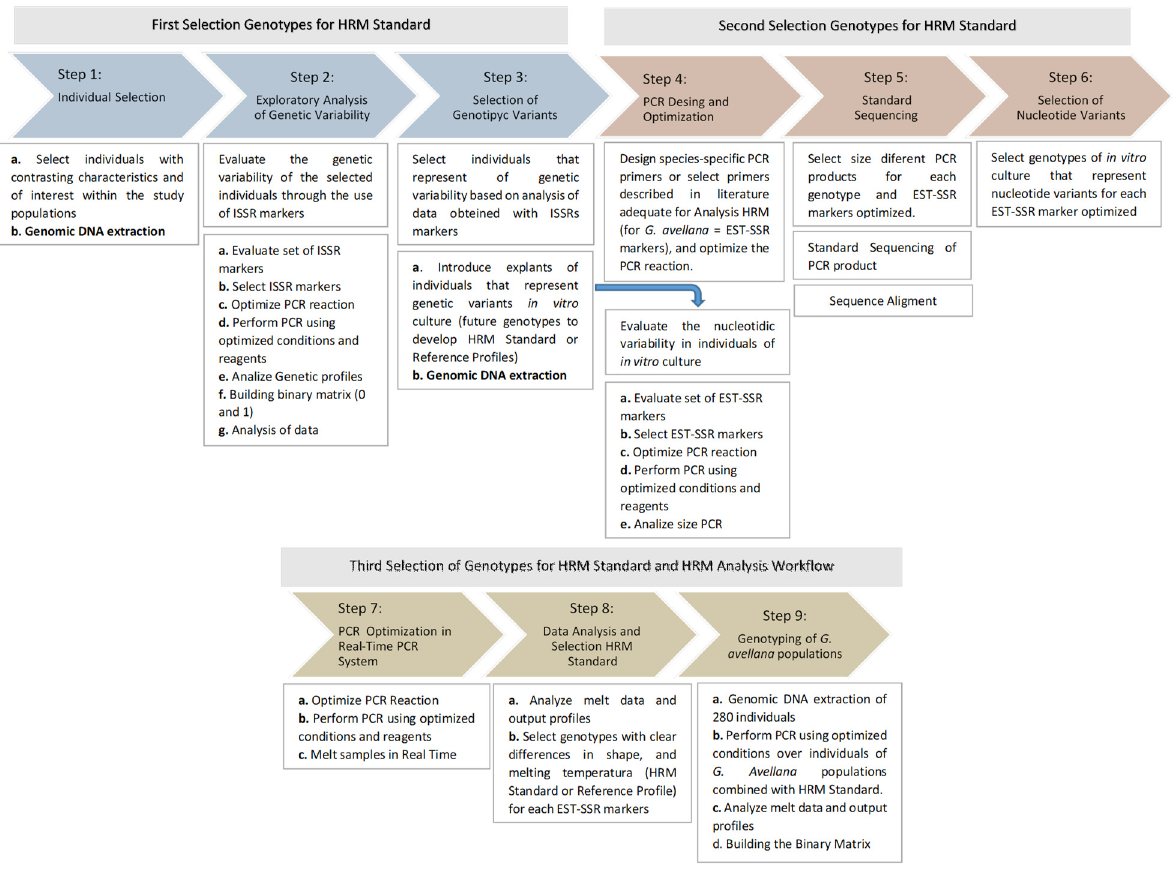
Figure 13. Scheme experimental workflow described for the genetic analysis of G. avellana Mol.